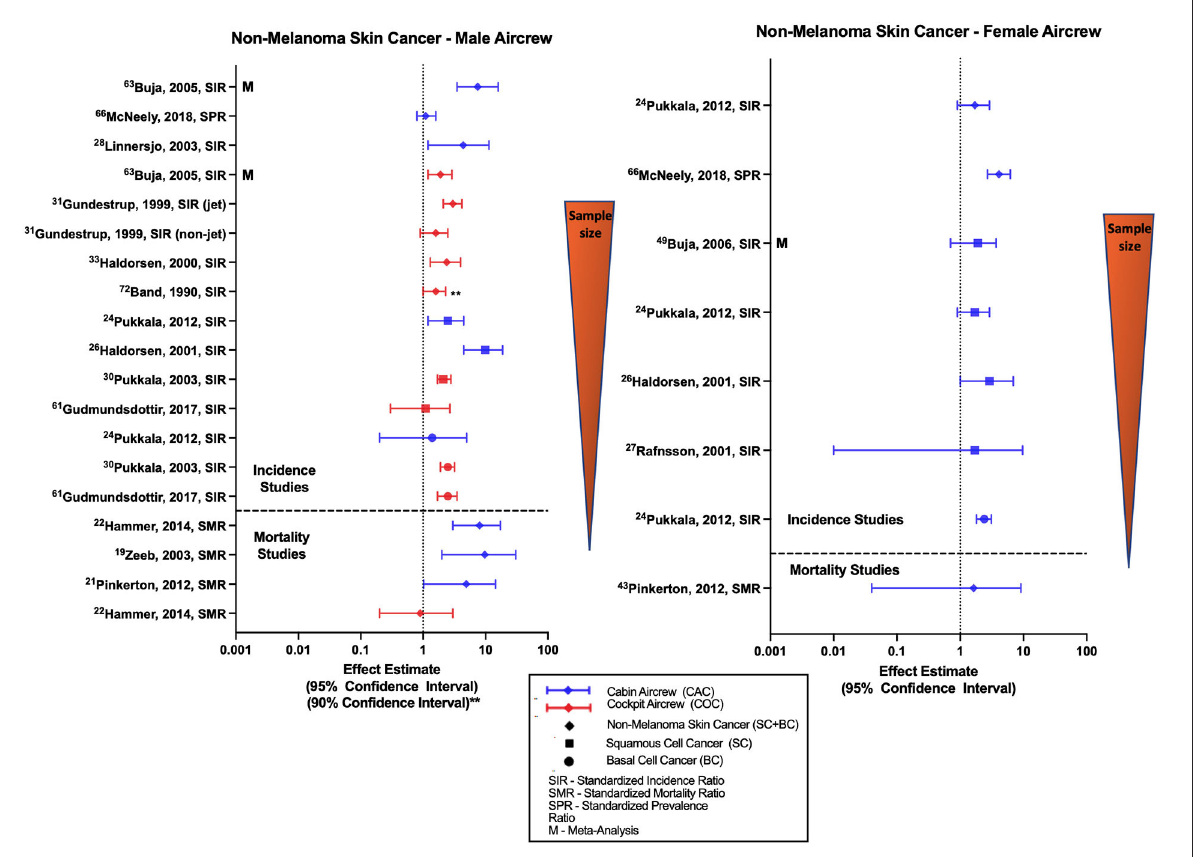
FIGURE3 Forest plot for studies evaluating non-melanoma skin cancer incidence or mortality ratios among male (left hand side graph) and female aircrew (right hand side graph) in association to CIR